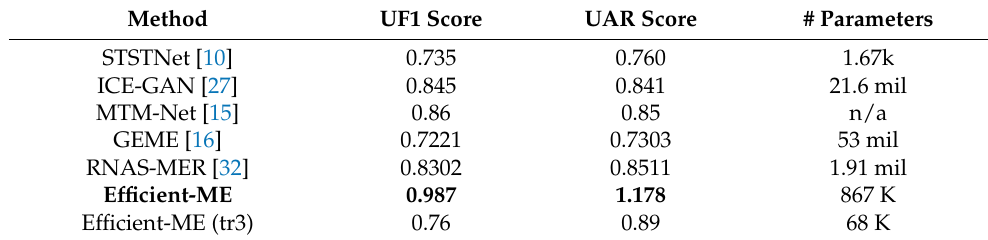
Table 4. UF1 and UAR scores against baseline methods on composite dataset.